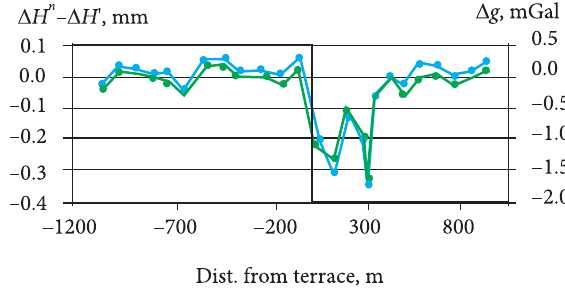
Fig. 7. Value of ' n H H ∆ − ∆ (green line) and the gravity change g ∆ between two station points (blue line) for the Tabasalu profile, an illustrative shape of the terrace (black line)